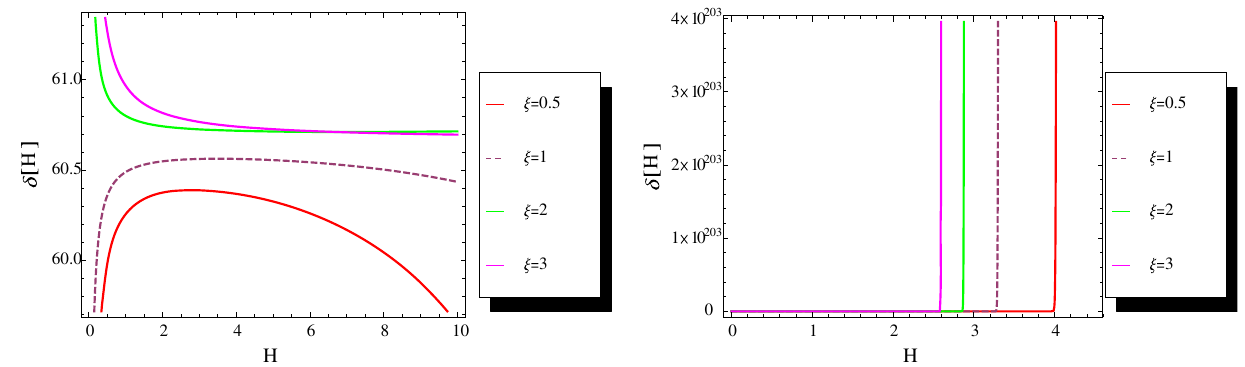
Fig. 5 We are illustrated through these graphs the behavior of δ versus the Hubble parameter. The first and second model of viscosity param- eter are depicted in the both graphs for fixed values γ = 7, h = 1, H o = 1, e = 12, ρ o = 0 . 9. In the graph at the left hand-side, we can see that at the beginning, the bulk viscosity increases (for low interact-